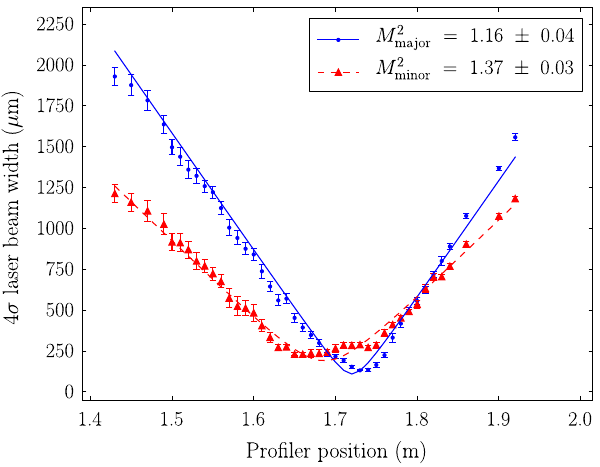
FIG. 10. Measured 4 σ widths of the laser beam through the focus created with a f ¼ 1 . 677 m lens. The M 2 model is shown for each intrinsic axis of the laser propagation, which were found to be rotated to the extrinsic lab axes by − 17 . 4 °.